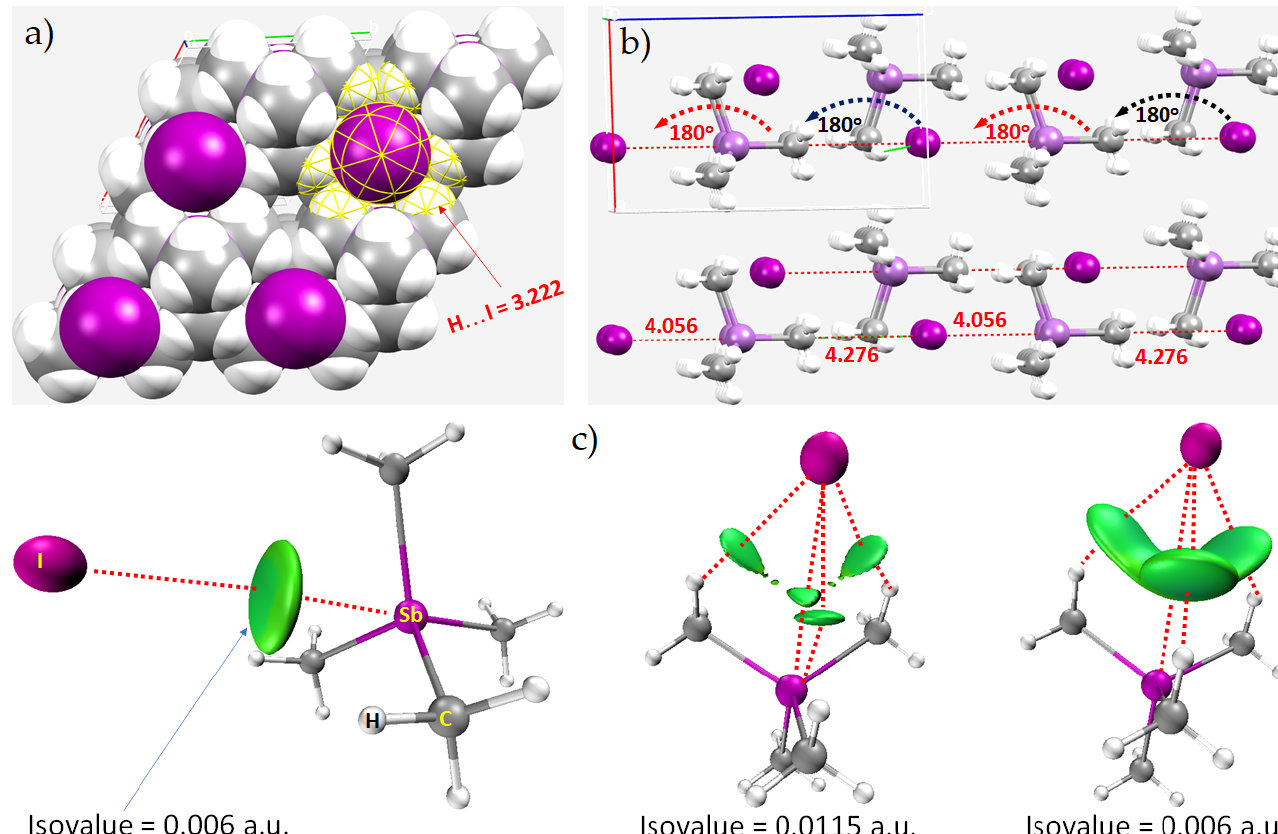
Figure 3. ( a ): The space-filling model of the unit-cell of [(CH 3 ) 4 Sb]I (CSD ref. code: SUCZEV). ( b ) The 2 × 2 × 2 supercell structure of the same crystal, with selected intermolecular distances and angles shown. ( c ) The IGM- δ g based isosurface plots for the ion-pair [Sb(CH 3 ) 4 ] + [I] − , obtained on the crystal geometry. Selected bond lengths and bond angles are in Å and degree, respectively. Dotted lines represent intermolecular interactions. Atom type is marked in ( c ).